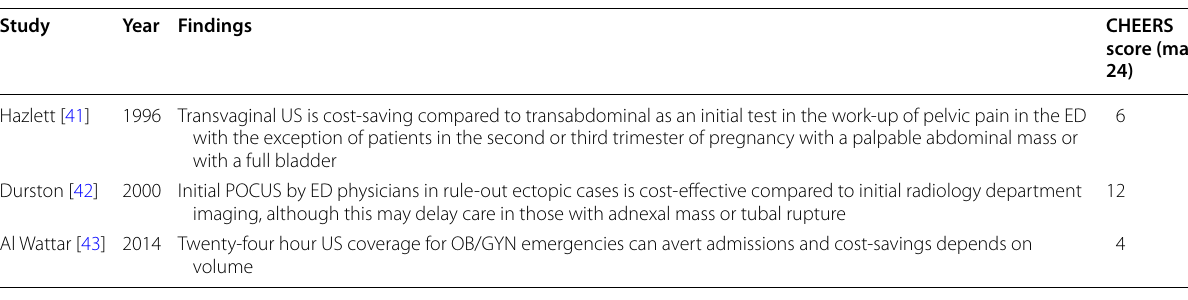
Table 4 Evaluation of OB/GYN pathology